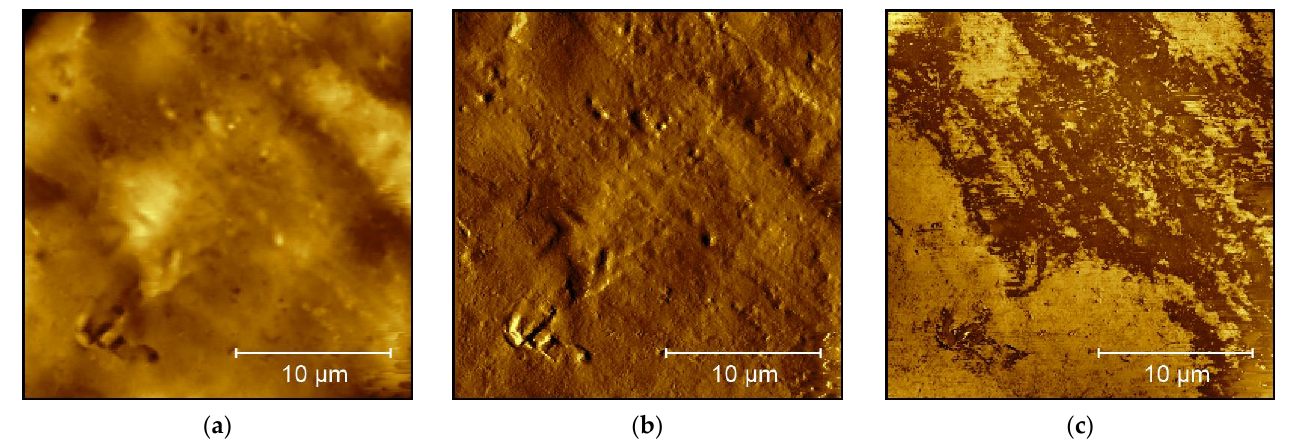
( c ) Figure 8. AFM images of a 3D printed PLA “temp” surface: ( a ) topography (height range 154 nm); ( b ) amplitude; ( c ) phase image (phase range 16°). Unexpectedly, this is different for the filament PLA “UV” from the same producer, as shown in Figure 9. Here, strong phase differences are visible (Figure 9c), indicating either a polymer blend or an undesired contamination of the printed surface. Due to this